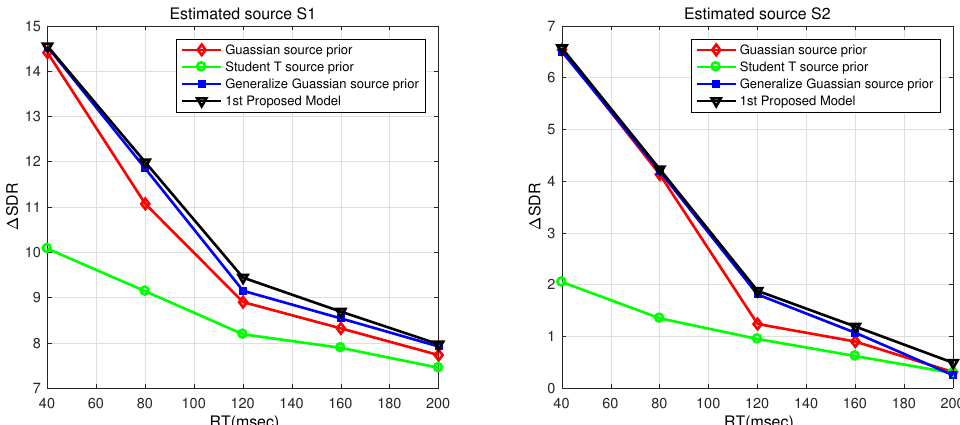
Figure 5. Change in SDR for convolutive pink noisy mixture with variable RT for the 1st proposed model.